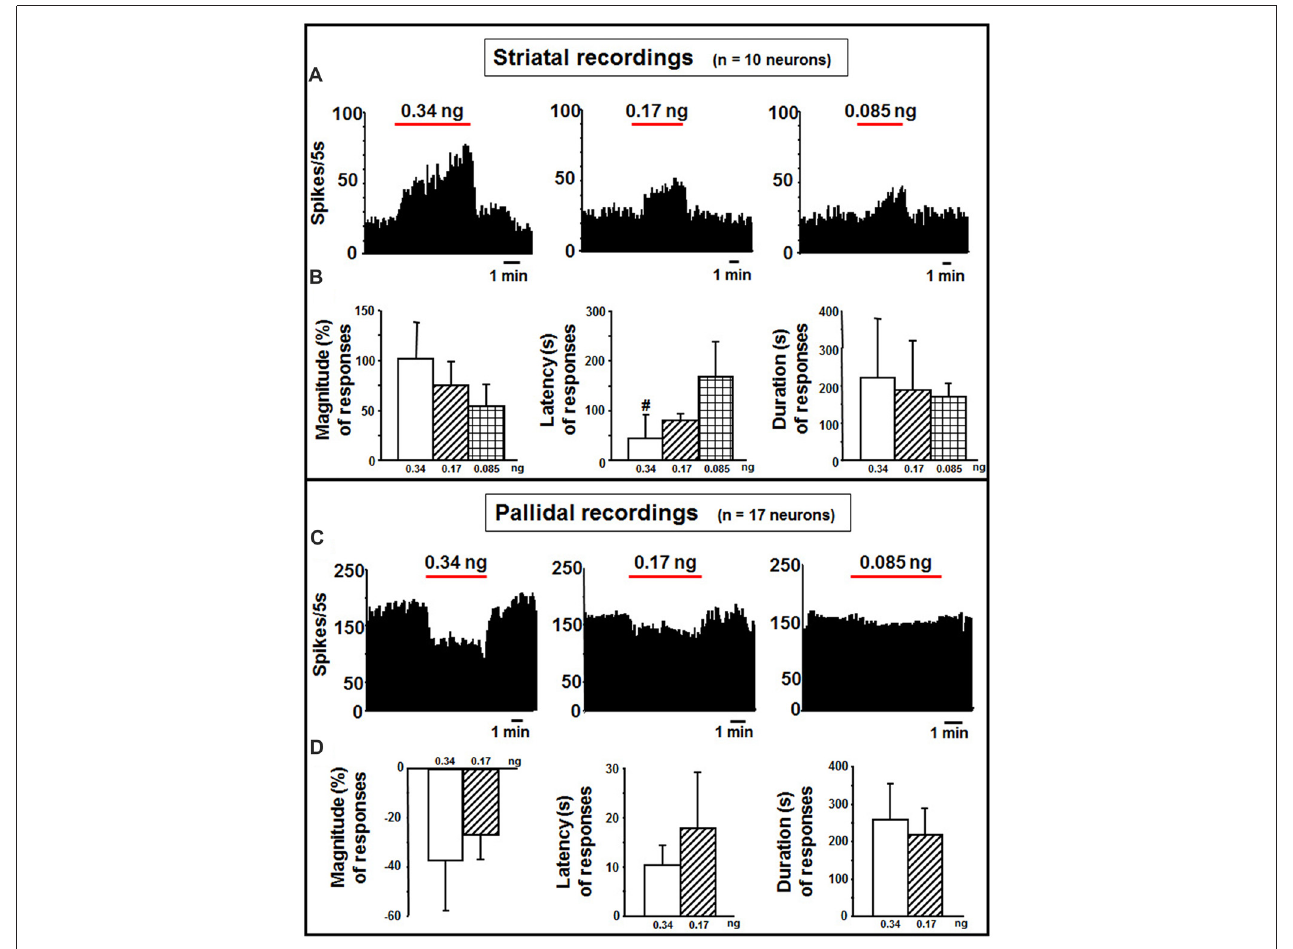
FIGURE 4 | Striatal and pallidal recordings. (A) Representative rate-meter histogram (bin width 5 s) showing the firing rate of a striatal neuron following indicaxanthin administration at various amounts (0.34, 0.17, 0.085 ng/neuron) for 5 min. (B) Bar histogram for magnitude, latency and duration showing the significant effect of indicaxanthin at different amounts (0.34, 0.17, 0.085 ng/neuron) on striatal neuronal responses ( n = 10). Each bar represents mean values ( ± standard deviation; # statistically significant effect of indicaxanthin 0.34 vs. 0.084 ng/neuron). Statistical significance for P < 0.05. (C) Representative rate-meter histogram (bin width 5 s) showing the firing rate of a pallidal neuron following indicaxanthin administration at various amounts (0.34, 0.17, 0.085 ng/neuron) for 5 min. (D) Bar histogram for magnitude, latency and duration showing the significant effect of indicaxanthin at different amounts (0.34, 0.17, 0.085 ng/neuron) on pallidal neuronal responses ( n = 17). Each bar represents mean values ( ± standard deviation). Statistical significance for P <